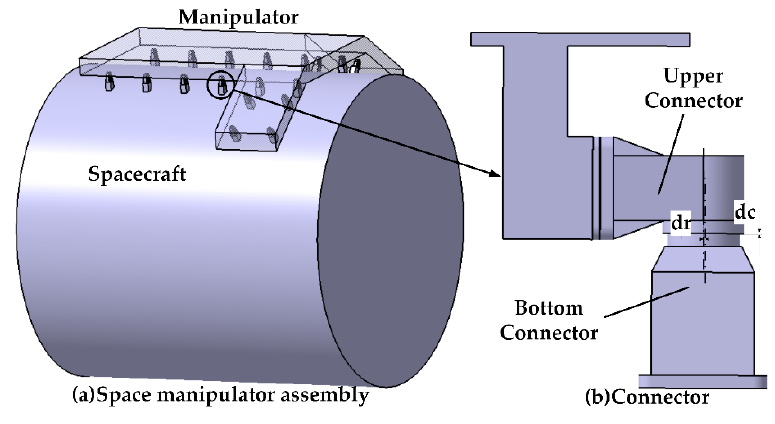
Figure 9. Space manipulator assembly.